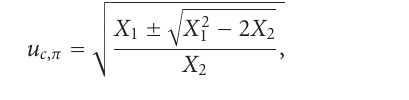
shapes applied at V gin ( V din ). The voltages biasing the gate and drain lines are denoted by V G1 and V D1 ,